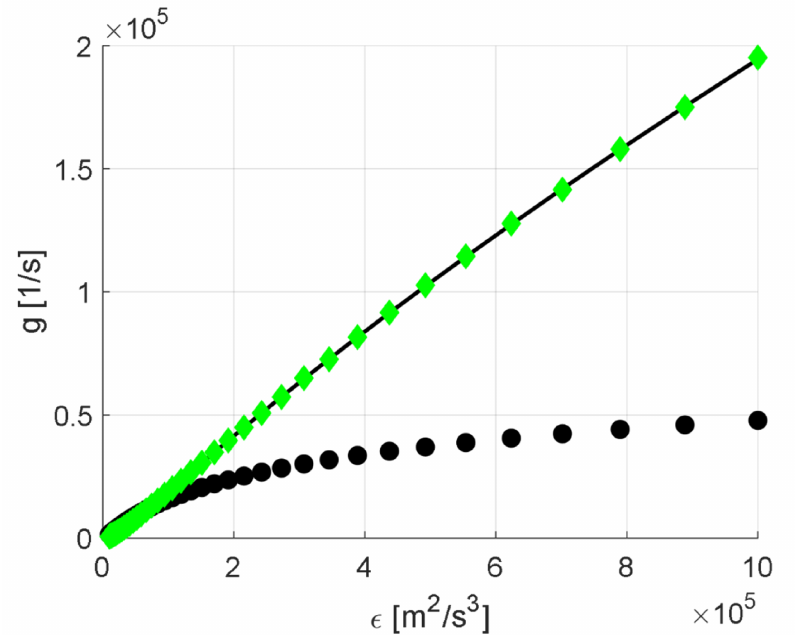
Figure 9. Ability of the Sofia and Birmingham method to capture the dependence of g on turbulent intensity (as measured by the dissipation rate of turbulent kinetic energy, ε ) with a realistic frag- mentation rate. Solid line shows true (set) g . Black circles: Birmingham method. Green diamonds: Sofia